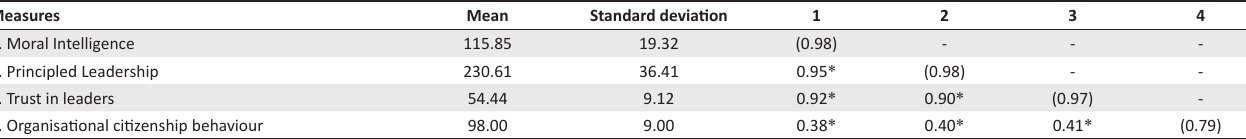
TABLE 1: Descriptive statistics and Pearson correlations ( N = 300). Measures